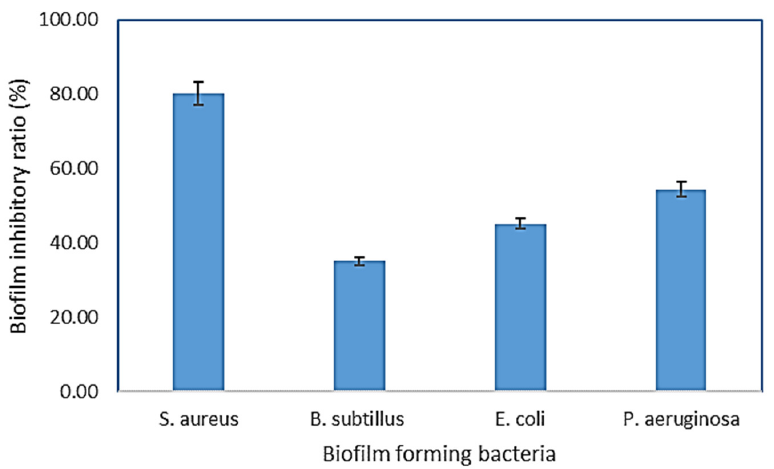
Figure 4. AP5-EtOAc extract inhibits biofilm formation in P. aeruginosa, S. aureus, E. coli, and B. subtilis. The microtiter plate test and the crystal violet assay measured the biofilm. The graph’s bars show the mean ± SD as a percentage of biofilm inhibition.